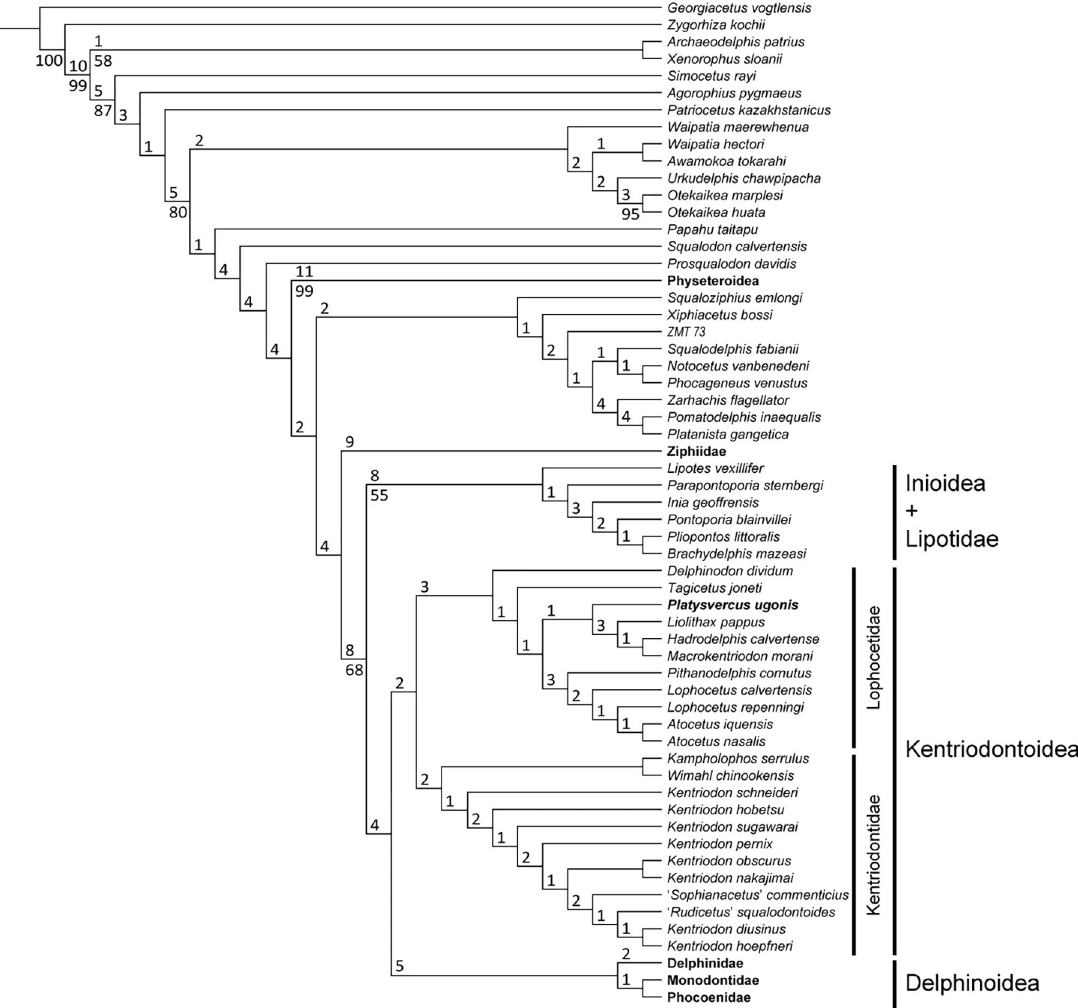
Fig 7. Phylogenetic relationships of Platysvercus ugonis gen. et sp. nov. Strict consensus tree resulting from 52 most parsimonious trees with tree constrained by the molecular trees of McGowen et al. [24–26], 3385 steps long, with the consistency index = 0.197 and the retention index = 0.568. Numbers above the nodes are Bremer support. Numbers below nodes indicate bootstrap values (1,000 replicated). The values less than 50% were omitted. The interspecific relationships of the Physeteroidea, the Ziphiidae, the Delphinidae, the Phocoenidae and the Monodontidae were omitted and these taxa were integrated into